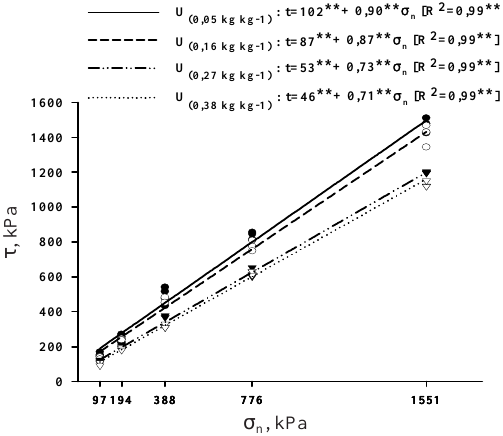
4. Relação linear simples entre a